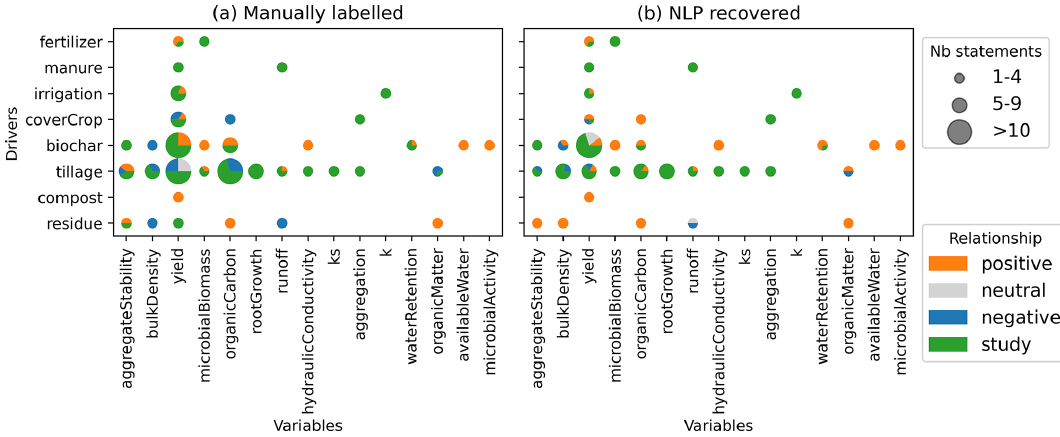
Figure 9. Relationships between drivers and variables as (a) manually labeled and (b) recovered by NLP for the Meta corpus.